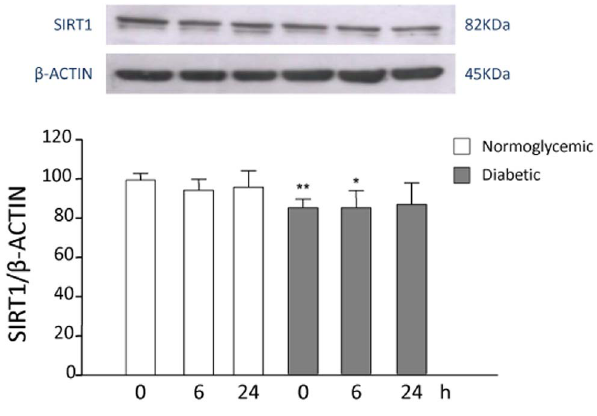
Figure 4. SIRT1 modulation under inflammatory stimulus by TNF- a . VSMCs from normoglycemic and STZ-diabetic rats were incubated with 30 ng/ml TNF- a for the indicated times; the amount of SIRT1 at baseline in normoglycemic VSMCs was taken as 100%. A representative Western blot is shown. Values are mean 6 SEM (n=6). * p , 0.05, ** p , 0.01 vs control.